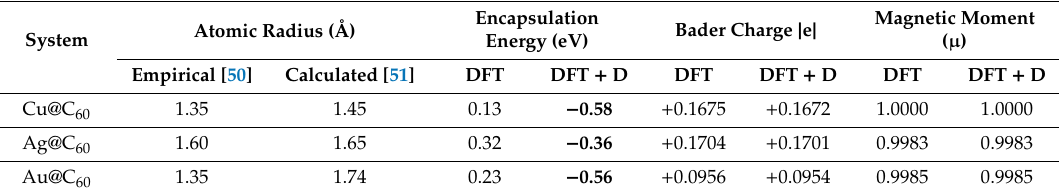
Table 2. Encapsulation energies of single coinage metal atoms incorporating the C 60 molecule, Bader charges on metal atoms and magnetic moments of the resultant composites.